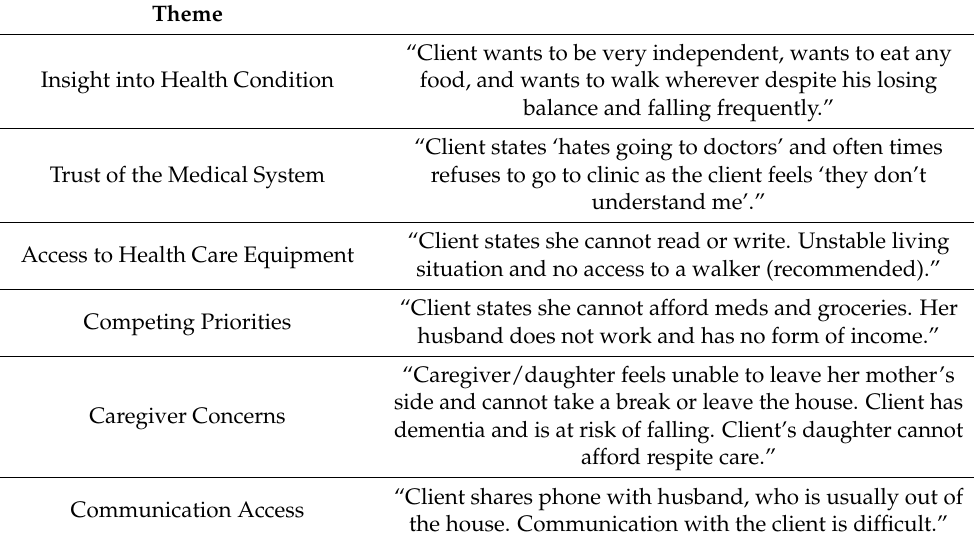
Table 2. Key concerns identified during the transition